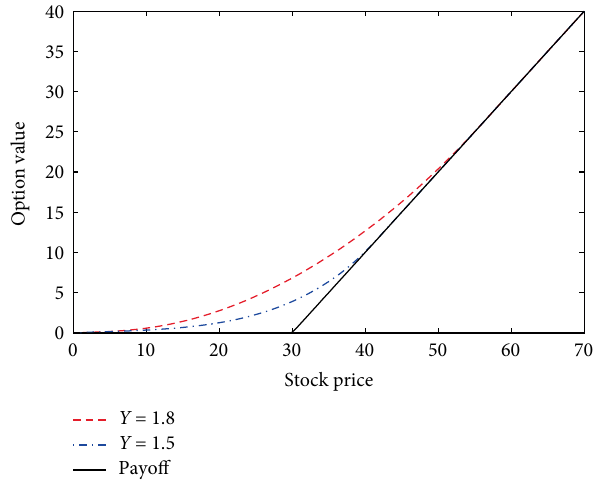
Figure 3: American call option prices